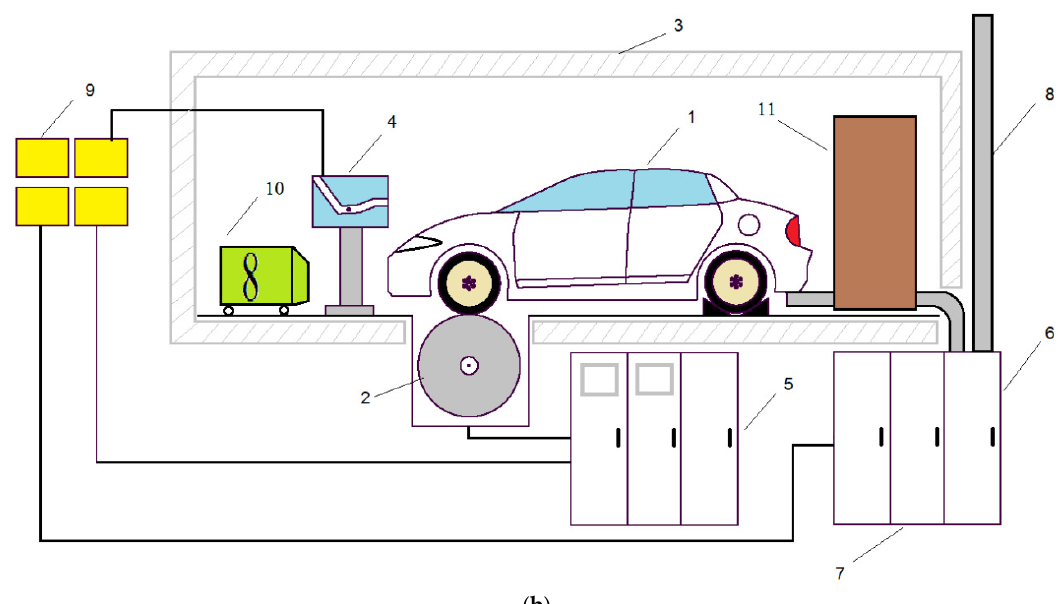
Figure 1. Test stand: ( a ) photograph of a hybrid vehicle on the test bench, ( b ) test stand scheme: 1—Tested vehicle, 2—Chassis roller, 3—Climate chamber, 4—Driver’s assistance monitor, 5—Chassis dynamometer control system, 6—Constant volume sampling system, 7—Exhaust gas analysis system, 8—Exhaust gas system, 9—Control room, 10—Cooling fan, 11—Remote mixing unit.